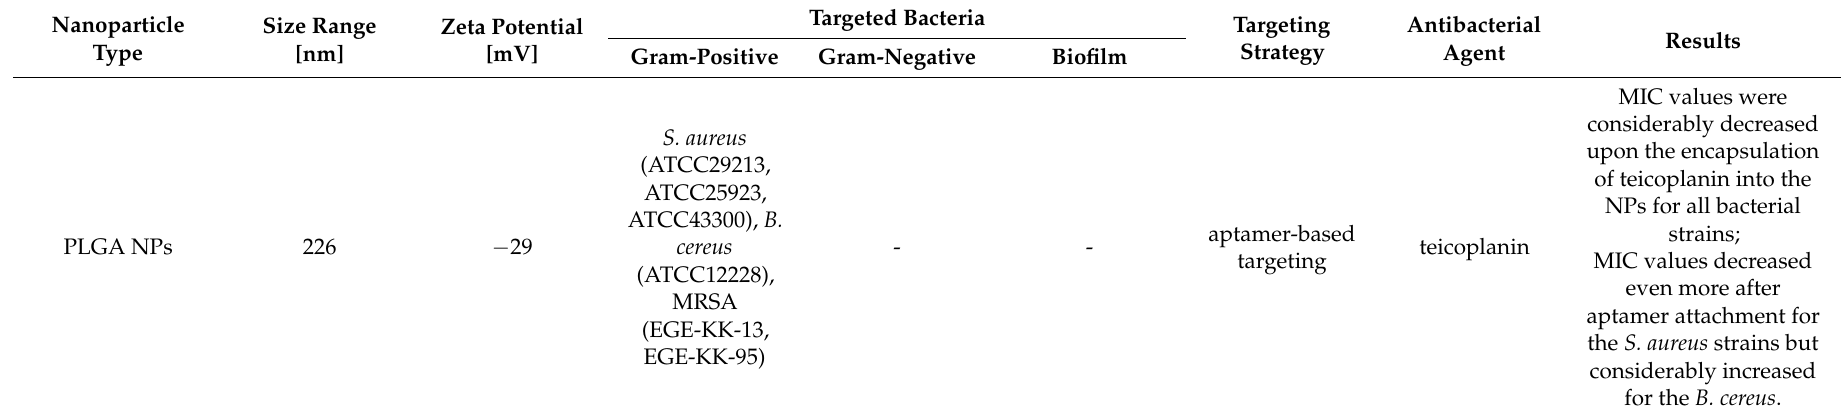
Table 2. Summary of the identified studies investigating the antibacterial properties of nanoparticles synthesized from synthetic